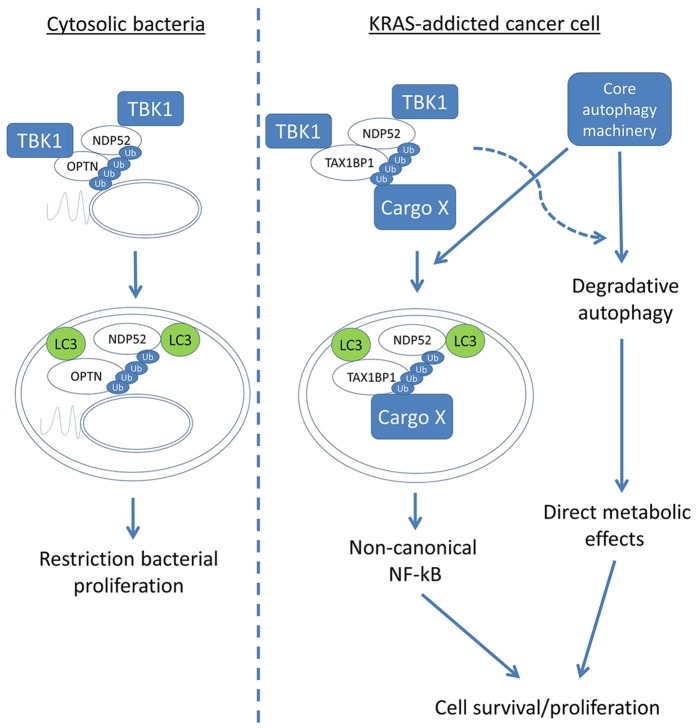
Model of autophagy function in K-Ras addiction versus xenophagy.See text for detailed discussion. Ub = ubiquitin.